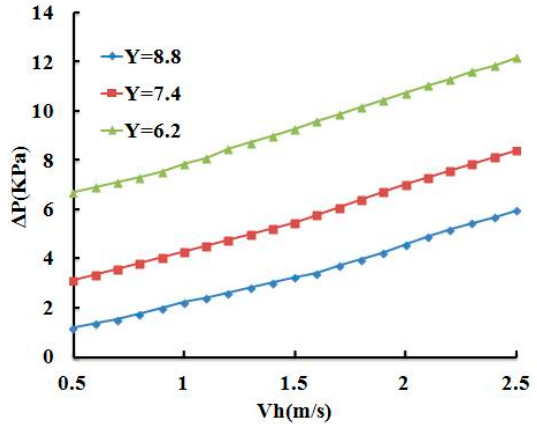
Figure 9. Effect of twist rate on pressure drop (Pressure P = 4.5 MPa, Temperture T = 3 °C).